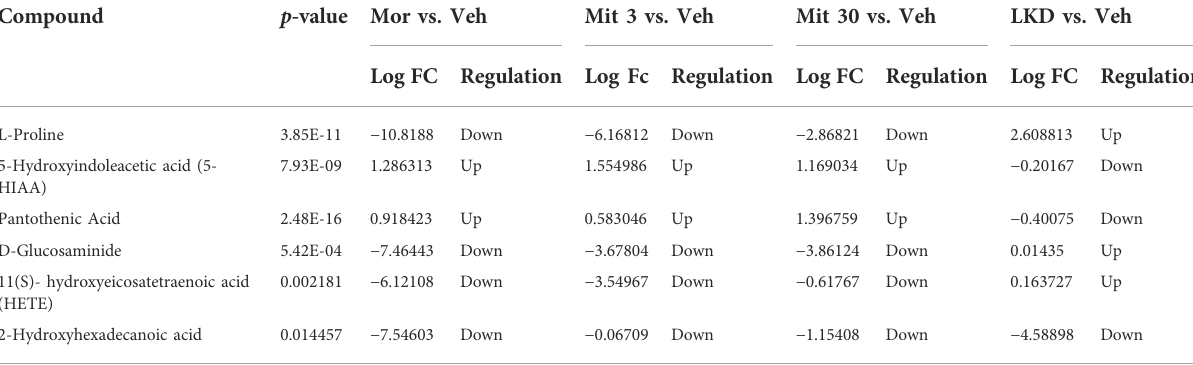
TABLE2Listofmetaboliteswithsigni fi cantexpressionidenti fi edindifferenttreatmentgroupsofadolescentratscomparedtovehicle-treatedgroup.